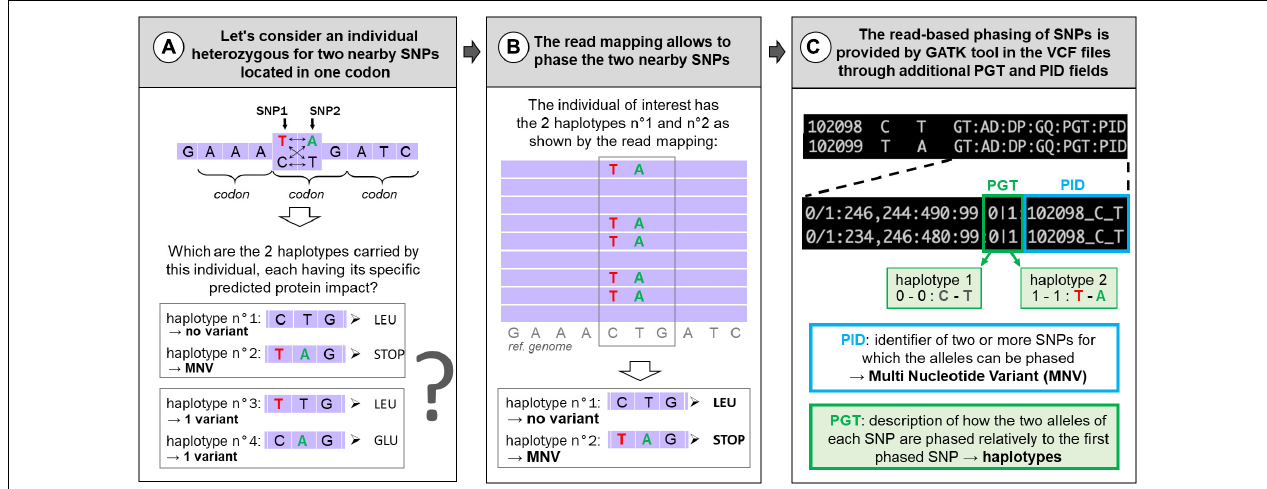
FIGURE 1 | Example of MNVs: predicted impact on the associated protein (A) and how to identify them (B,C) . (A) Example of an MNV composed of two nearby SNPs in one codon and its four potential haplotypes in the population and their predicted impact on the associated protein. In contrast to other haplotypes, haplotype no. 2 contains two variants (T and A) and corresponds to an MNV. (B) The IGV (Integrated Genome Browser; Robinson et al., 2011) screen shot indicates the principle of read-based phasing of SNPs: short read mapping against the reference genome of the heterozygous individual allows us to phase both SNPs giving two haplotypes: C with T (reference alleles) on one side and T with A (alternative alleles) on the other side. When translated, these two haplotypes correspond to a leucine or a STOP codon and not to a simple amino acid change ( LEU → GLU ) if the two haplotypes had been composed by only one reference and one variant as shown in (A) . (C) Information (PID and PGT) provided by GATK in the VCF files about the phased SNPs according to the read-based phasing shown in (B)